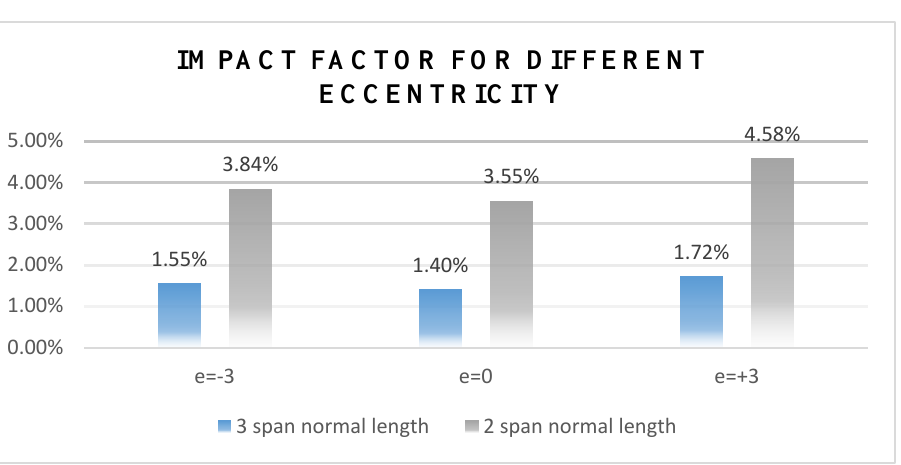
Fig. 12. Impact factor for different